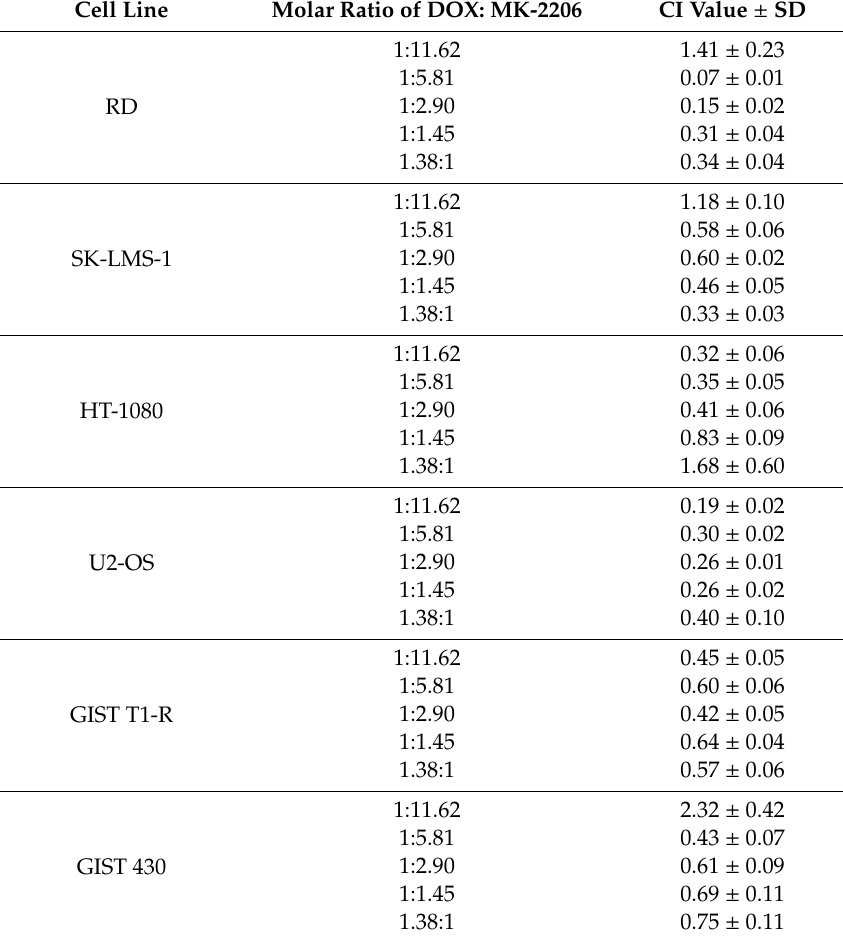
Table 2. CI values for each molar ratio of Dox and MK-2206 in STS and